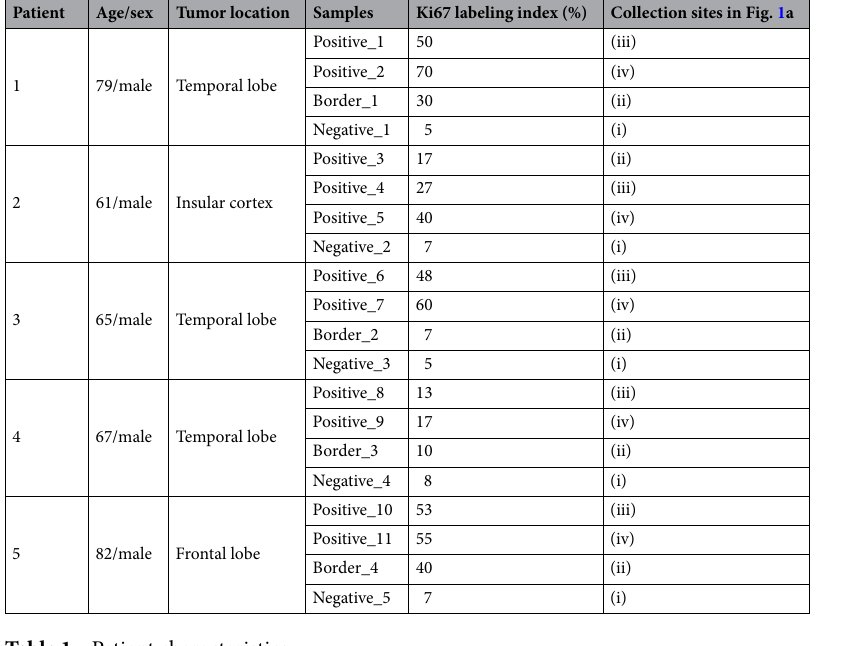
Table 1. Patient